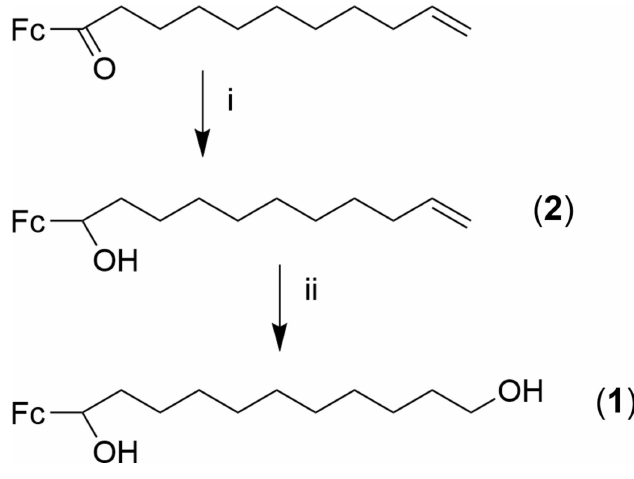
Figure 8 Preparation scheme for 1 ; (i) LiAlH 4 , Et 2 O; (ii) 9-BBN, THF.